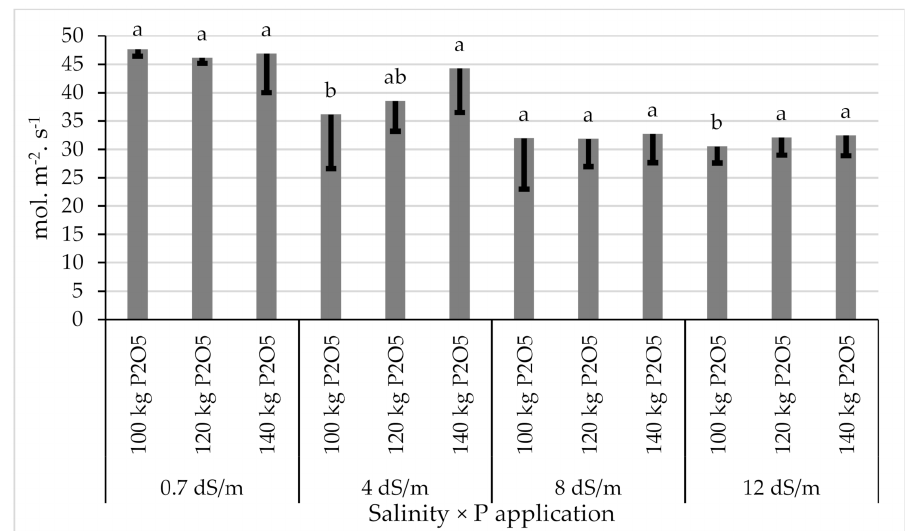
Figure 5. Variation of stomatal conductance under different salinity levels and P application. Error bars indicate the standard deviation. Phosphorus treatments under the same salinity level without a common letter are significantly different at p <